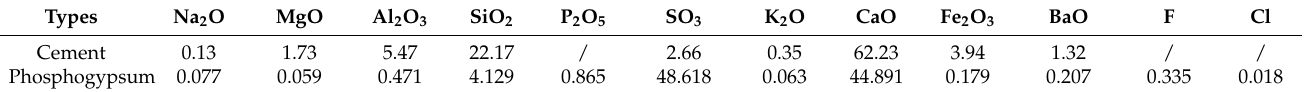
Table 1. Main chemical compositions of phosphogypsum/wt.%.